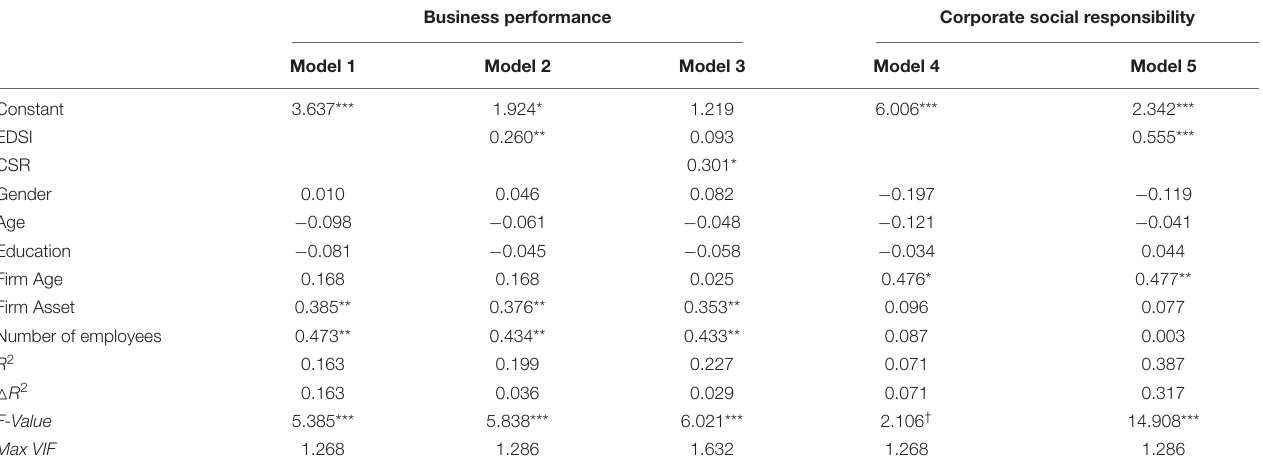
TABLE 4 | The direct and indirect effects of entrepreneurs’ Darwinian social